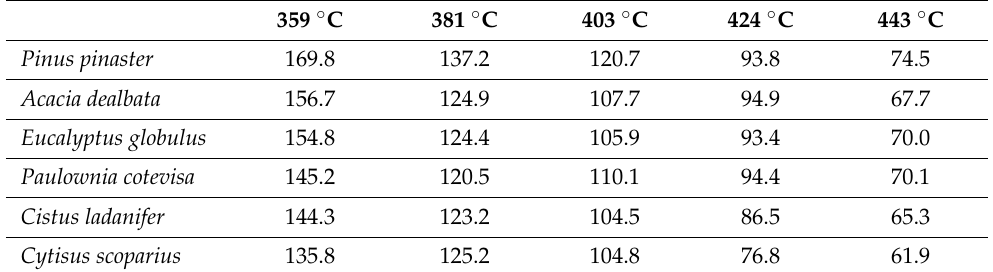
Table 5. Pellet ignition time (s).